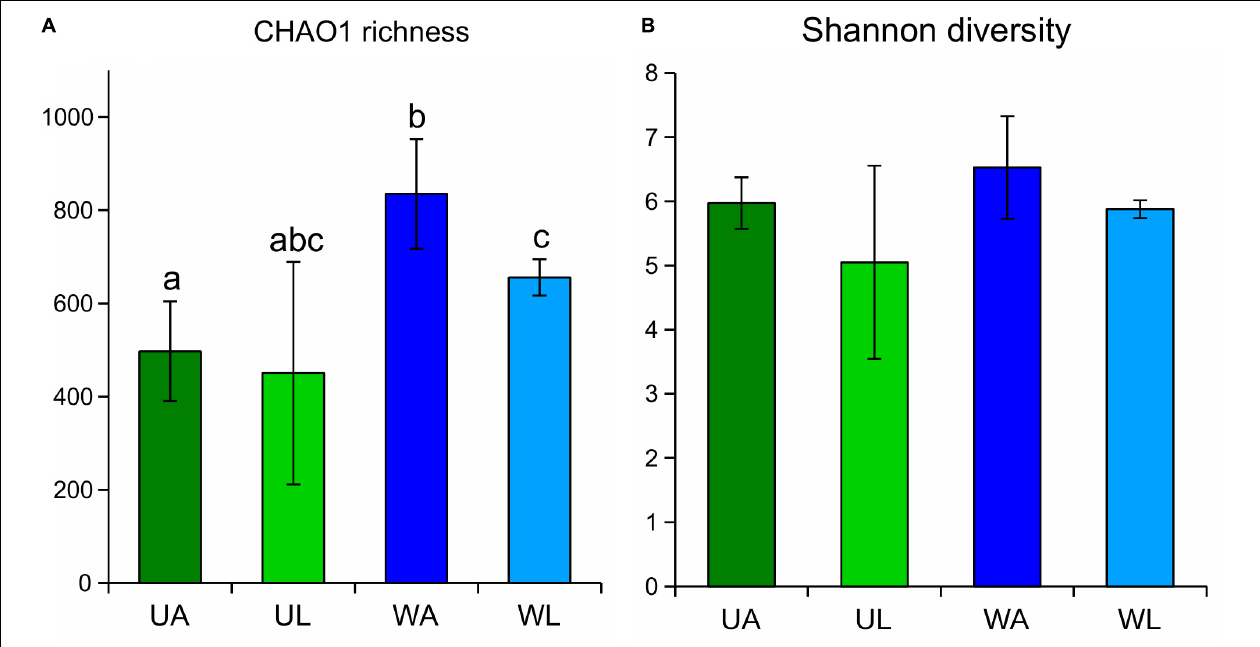
FIGURE 3 | CHAO1 richness estimates (A) and Shannon diversity index (B) obtained for Ulva -associated and surrounding water microbiomes based on 16S rRNA gene. Estimates obtained for Ulva -associated (UL, Ulva from lagoon; UA, Ulva from aquaculture) and water samples (WL, water from lagoon; WA, water from aquaculture) prokaryotic communities are shown with corresponding standard deviation (error bars). Significant differences ( p -value ≤ 0.05) between microhabitats are highlighted by different letters on top of the bars. TABLE 2 | Kruskal–Wallis pairwise tests on alpha-diversity indexes obtained for all combinations of samples. Group 1 Group 2 CHAO1 p -value ( q -value) Shannon p -value ( q -value)